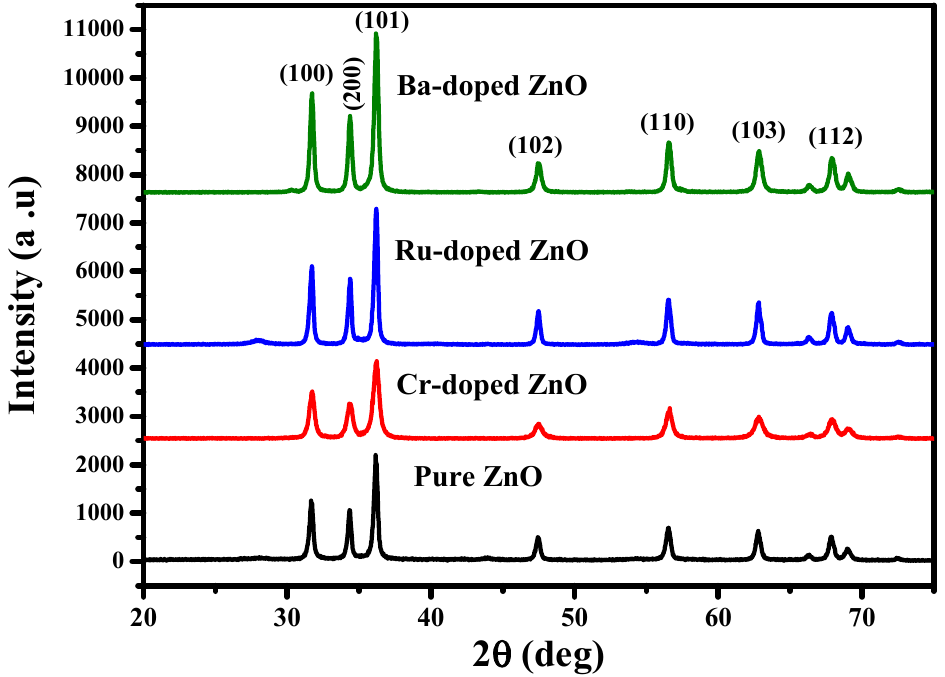
Figure 1. The XRD pattern of ZnO, CrZnO, RuZnO, and BaZnO nanomaterials.